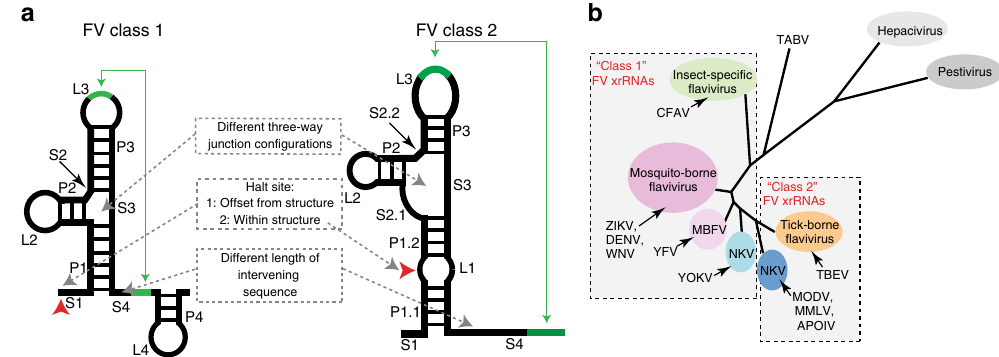
Fig. 6 Correlation of classes of fl avivirus xrRNA with viral phylogeny. a Cartoon representation of the basic secondary structure of two types of fl avivirus xrRNAs. The secondary structural elements in each are labeled with a proposed nomenclature. Key differences between the two are described. Green lines and arrows indicate long-range base pairing, red arrows indicate the halt point for Xrn1. b The phylogenetic tree of the Flaviviridae is an adaptation from Vlachakis et al. 52 . Shaded boxes indicate the clades of viruses that have similar classes of xrRNA, based on our structural and functional analysis. There are two clades of NKVFVs; one group has ‘ Class 1 ’ xrRNAs that match the mosquito-borne viruses, and the other has ‘ Class 2 ’ xrRNAs that align with the tick- borne viruses. Abbreviations not used in main text: ZIKV: Zika virus; POWV: Powassan virus; TABV: Tamana bat virus